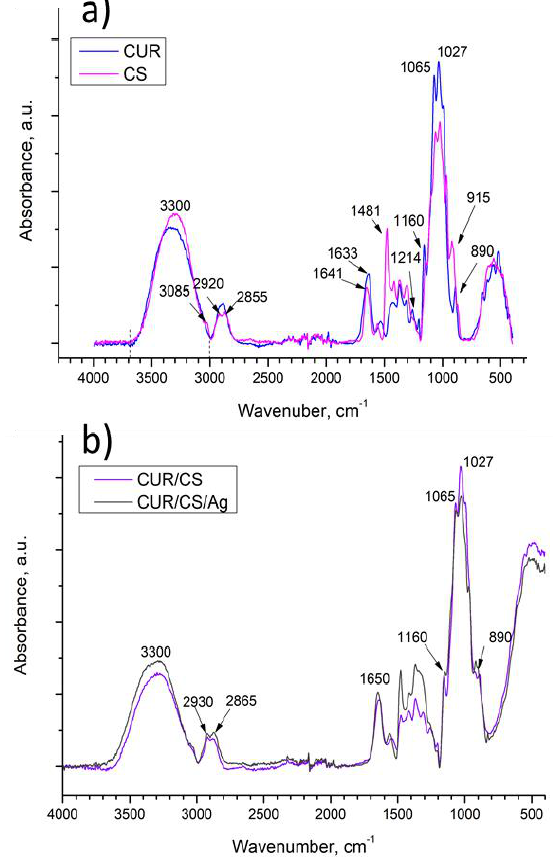
Figure 7. FTIR spectra of curdlan-chitosan ( a ), and CUR/CS and CUR/CS/Ag ( b ) biomaterials.